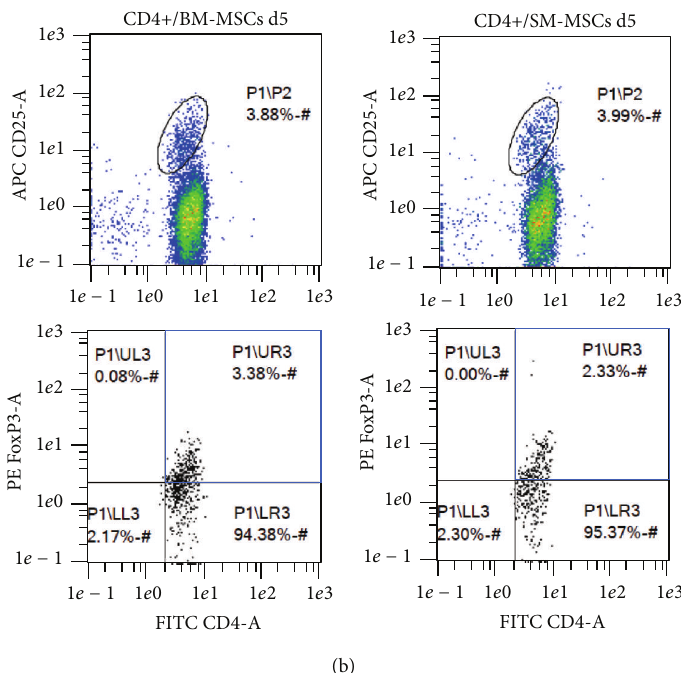
Figure 3: Surface marker expression on CD4+ T-cells in monocultures and MSC-cocultures. (a) The diagrams display the mean positive cells for CD4+CD25+FoxP3+, CD4+CD25+CD127-, CD45R0+ Tregs, and CD45RA+ Tregs as detected by flow cytometry ( 𝑛 = 10 ). ∗∗ 𝑝 < 0.01 and ∗∗∗ 𝑝 < 0.001 . (b) Representative flow cytometry plots for background fluorescence, CD4+ T-cell monocultures at day 0 and day 5, and the respective BM-MSC and SM-MSC cocultures at day 5. Lymphocytes were gated for CD4, CD25, and FoxP3.